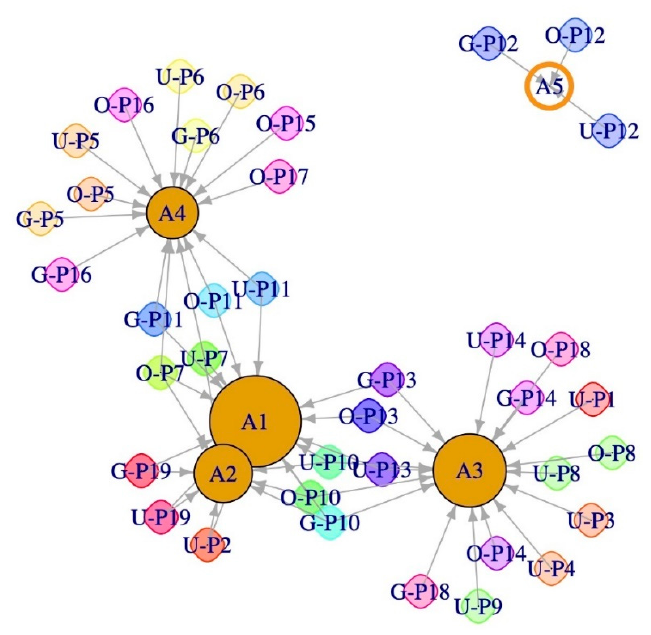
Figure 4. The network of stakeholders and associated factors (problems) for the five main areas.